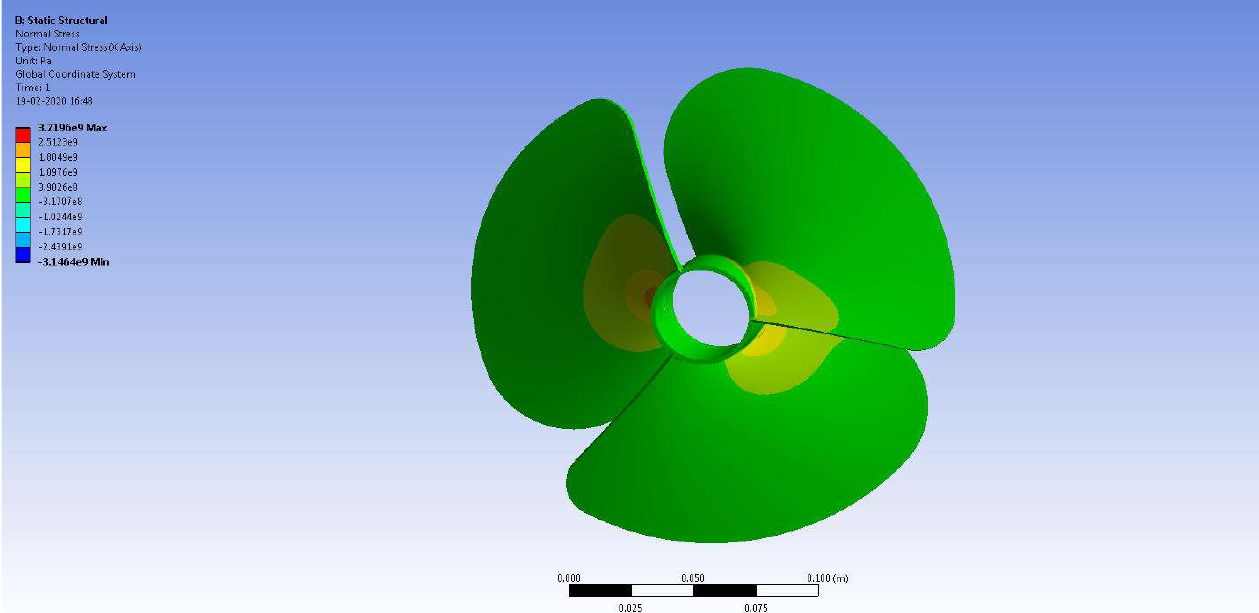
Figure 22. Distribution of deformation at 300 m depth with 20 m/s fluid veloci- ty—CFRP-Prepreg-Wn-395-GPa.